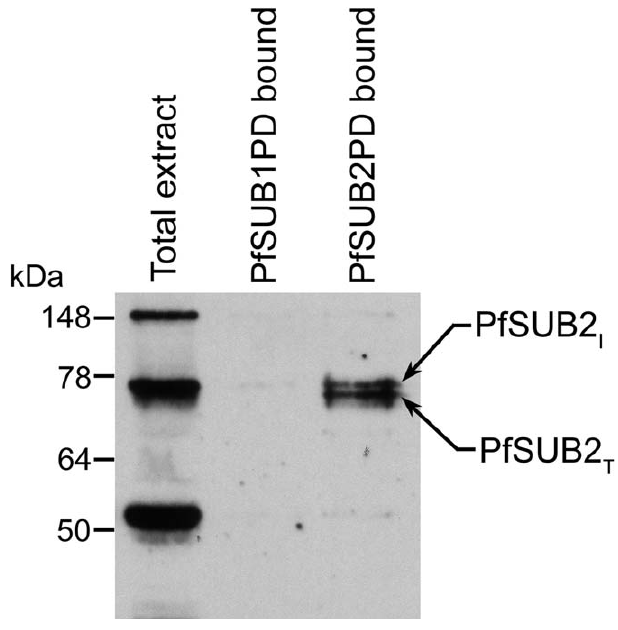
Figure 5. PfSUB2PD Binds to Mature Parasite PfSUB2 Sodium deoxycholate extracts of PfSUB2HA clone 2D were incubated with either purified PfSUB1PD or PfSUB2PD, then the propeptides were recovered with S-protein agarose and subjected to SDS PAGE and Western blot using anti-HA mAb 3F10. The PfSUB2 I and PfSUB2 T species bound by PfSUB2PD are indicated. Molecular mass markers are in kDa. DOI: